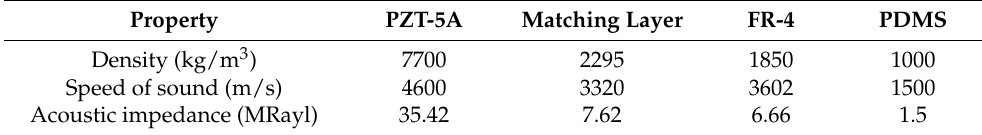
Table 1. Material properties used for